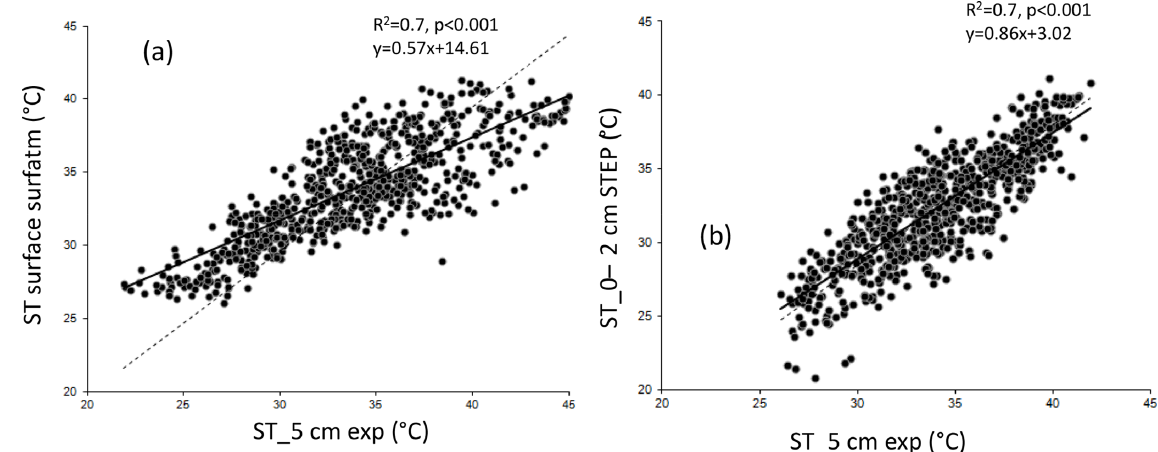
Figure 4. (a) Modelled daily surface temperature in Surfatm vs. measured daily temperature at 5cm depth; (b) modelled daily surface temperature in STEP (0–2cm layer) vs. measured daily temperature at 5cm depth. The thick black line is for the linear regression, and the dashed black line is the 1 : 1